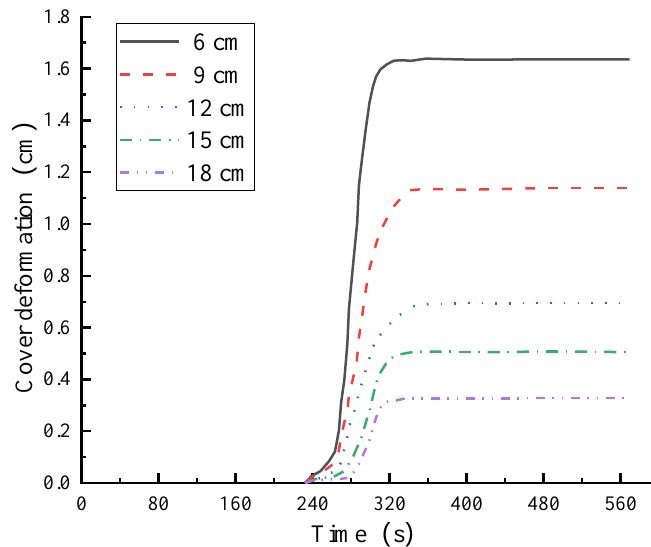
Figure 10. Declining water table cover settlement.